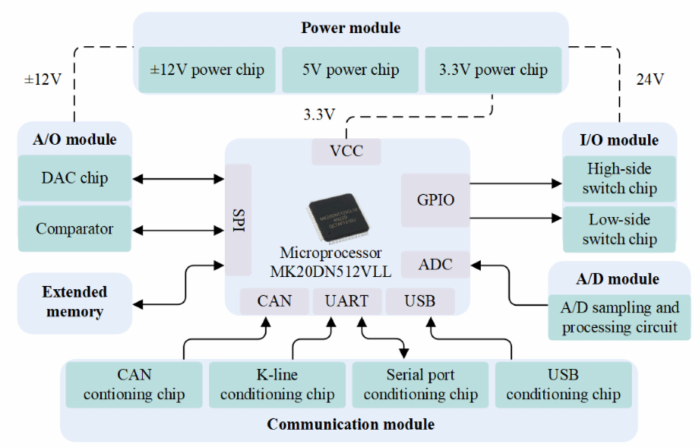
Figure 8. Hardware framework of the control